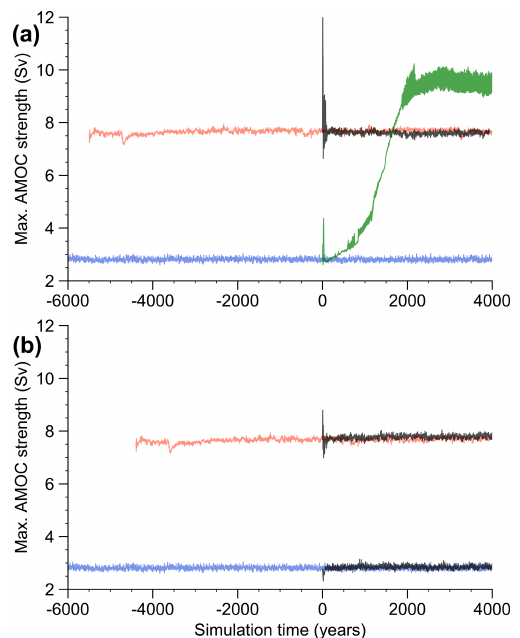
Figure 7. Time series of the maximum AMOC strength in ocean model simulations in which a short-term volcanic cooling is incor- porated into the atmospheric temperature boundary condition. The simulations (shown in black and green) are branched off in year 0 from the equilibrium simulations in the collapsed (blue) and vig- orous (red) AMOC states, and the volcanic perturbation is started simultaneously. The simulations with the NH–equatorial and SH scenario are shown in panels (a) and (b) ,